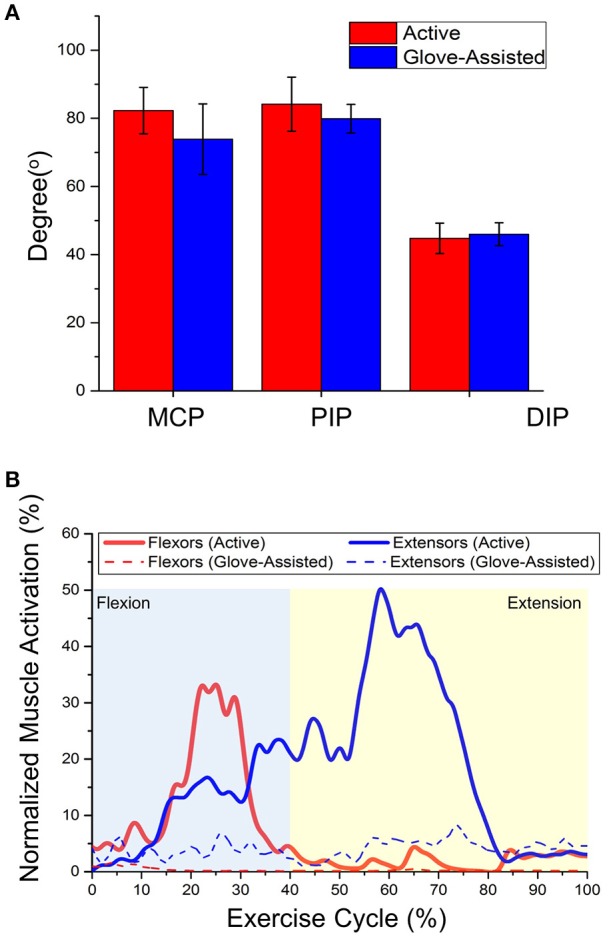
(A) Averaged range of motion of individual finger joints of five participants during active and glove-assisted trials. MCP, Metacarpophalangeal joint; PIP, Proximal interphalangeal joint; DIP, Distal interphalangeal joint. (B) Averaged muscle activation profiles of finger flexors and extensors of one representative subject (Subject 2) during active and glove-assisted trials. Exercise Cycle, Hand closing followed by opening.